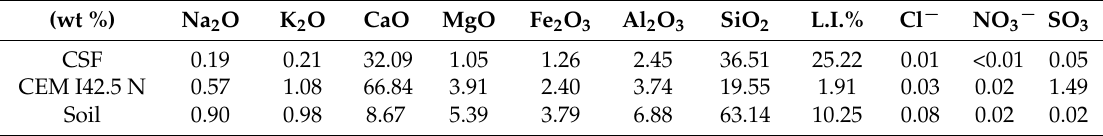
Table 6. Chemical composition of CSF and cement I42.5 N.